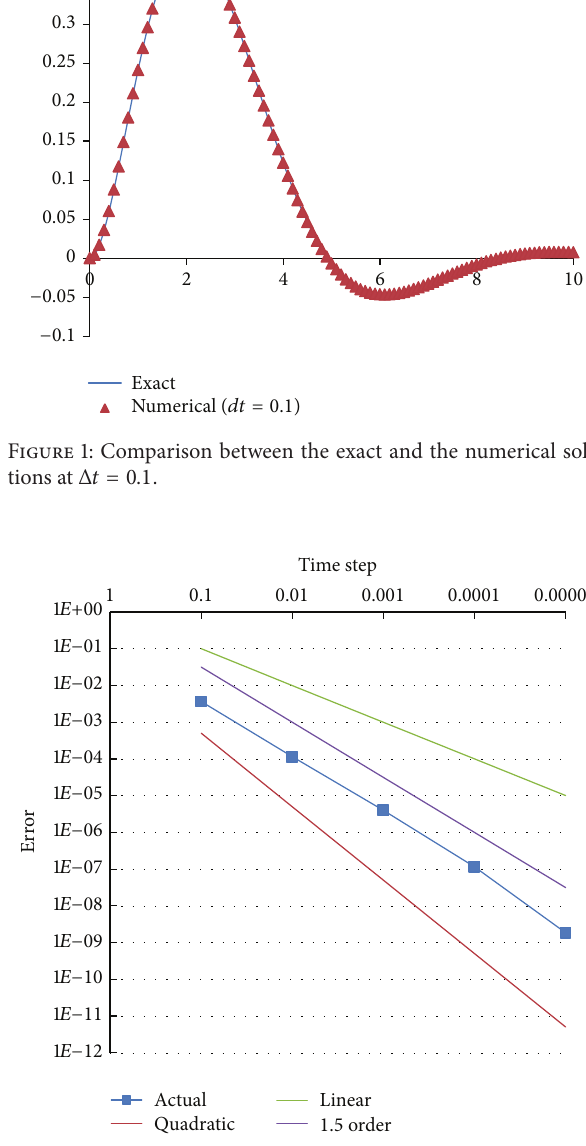
Figure 2: The convergence order of the developed numerical solver.